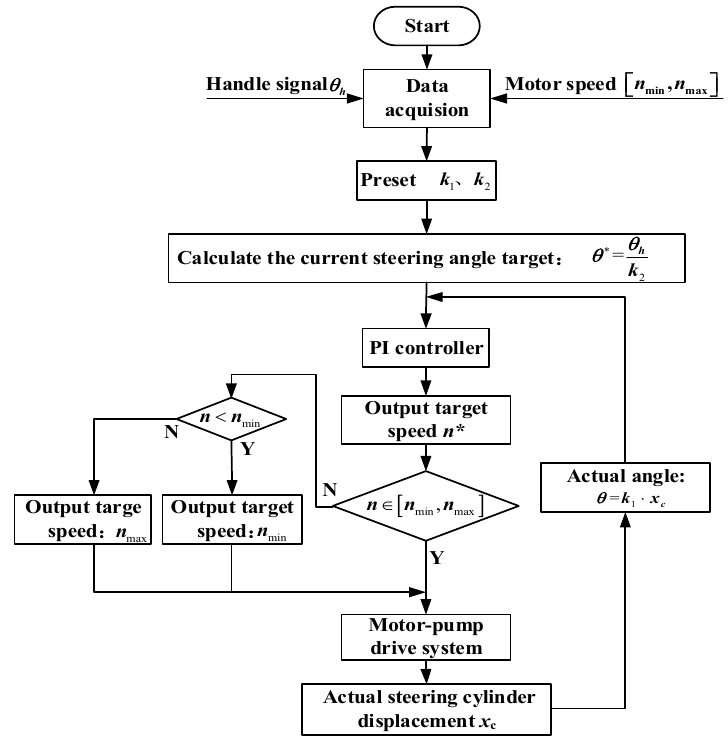
Figure 5. Flow chart of the closed-loop control strategy of steering angle.